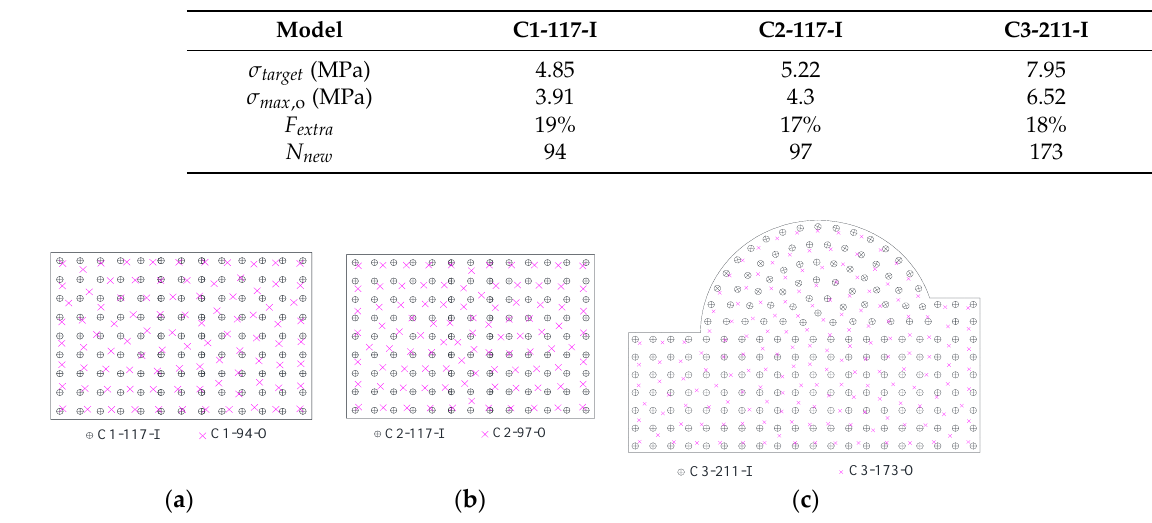
Table 6. Comparison of the three cases during AOM-ES.